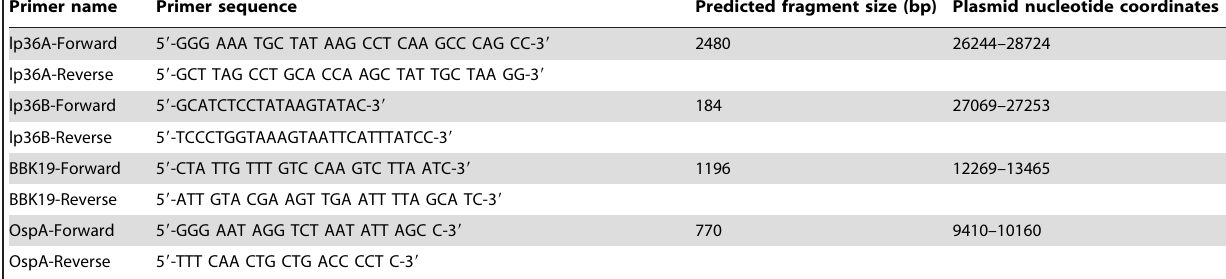
Table 4. Oligonucleotides used for plasmid content